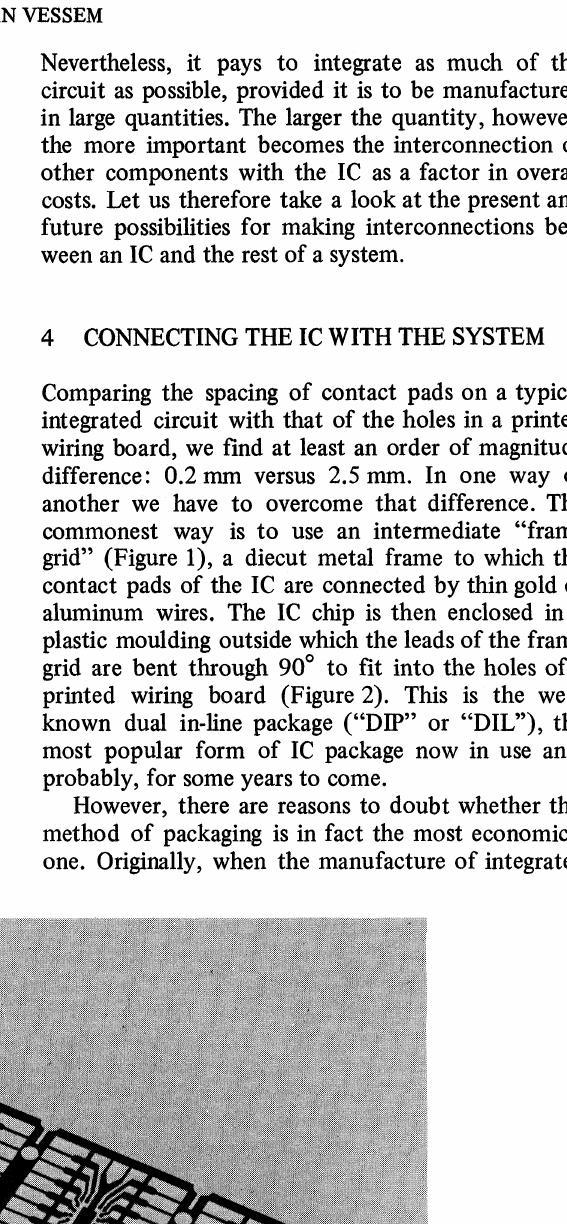
FIGURE Frame grid used for integrated circuit assembly (Approx.